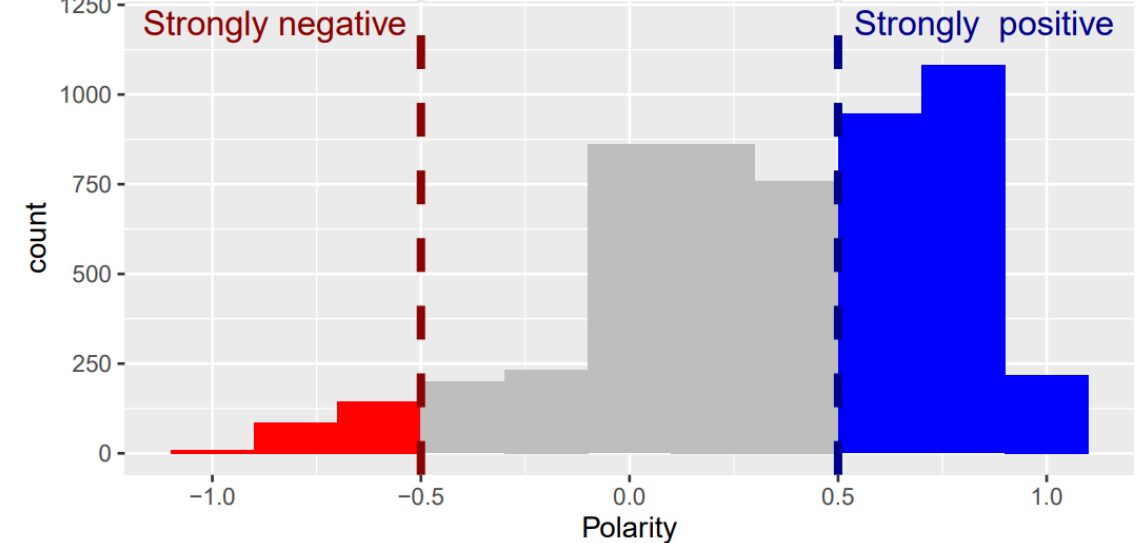
Figure 3. Polarity scores for tweets including BSS-related